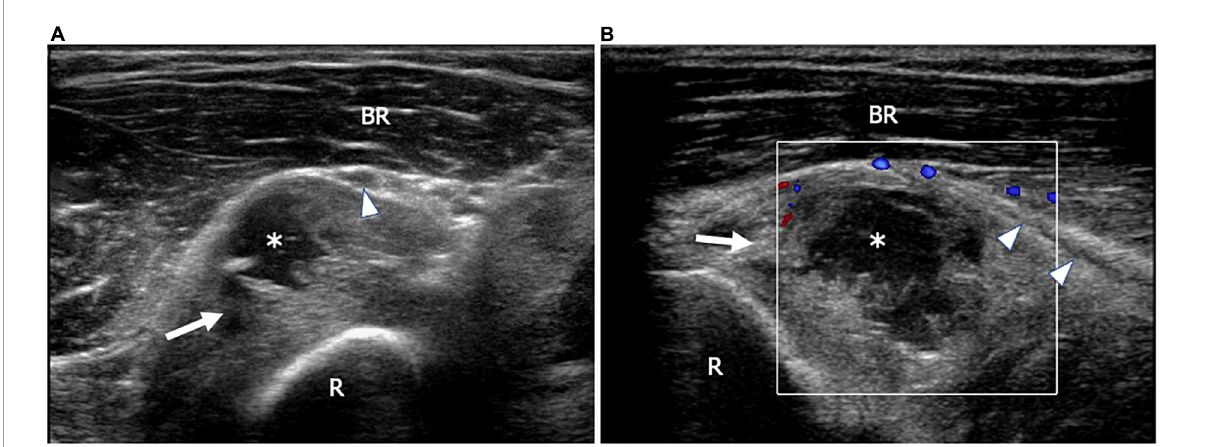
FIGURE2 This figure shows two 18 MHz HRUS images (A,B) of a 53 years old male patient affected by rheumatoid arthritis with a progressive decrease of fingers extension strength. (A) An axial view, immediately distal to the humeral-radial joint line, shows the annular recess (white arrow) distended by synovium and fluid (white asterisk); the recess dislocates superficially the posterior interosseus nerve (white arrowhead) immediately proximal to the supinator tunnel. After switching on the Eco-Color Doppler, a slight peripheral vascularization of the synovial wall of the annular recess (white arrow) is shown (B) . (B) The longitudinal scan also depicts the long axis of the posterior interosseous nerve (white arrowheads) dislocated superficially by the distended recess. BR, brachioradialis muscle; R,